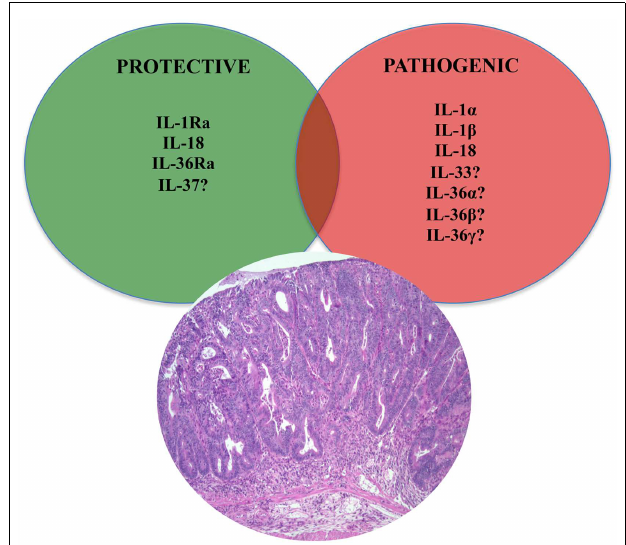
FIGURE 4 | Role of IL-1 family members in colon cancer . Similar to chronic intestinal inflammation characteristic of IBD, an imbalance between protective and pathogenic IL-1 family members is also an important mechanism leading to intestinal tumorigenesis and the development of GI-related cancers. In fact, IL-1 cytokines play an important role in sustaining tumor growth by stimulating growth factor production and modulating host immune responses against tumor cells.While the roles of classic IL-1 family members, such as IL-1 and IL-18, have been firmly established, only speculation can be made on other, newer IL-1 family members, such as IL-33, IL-36, and IL-37.